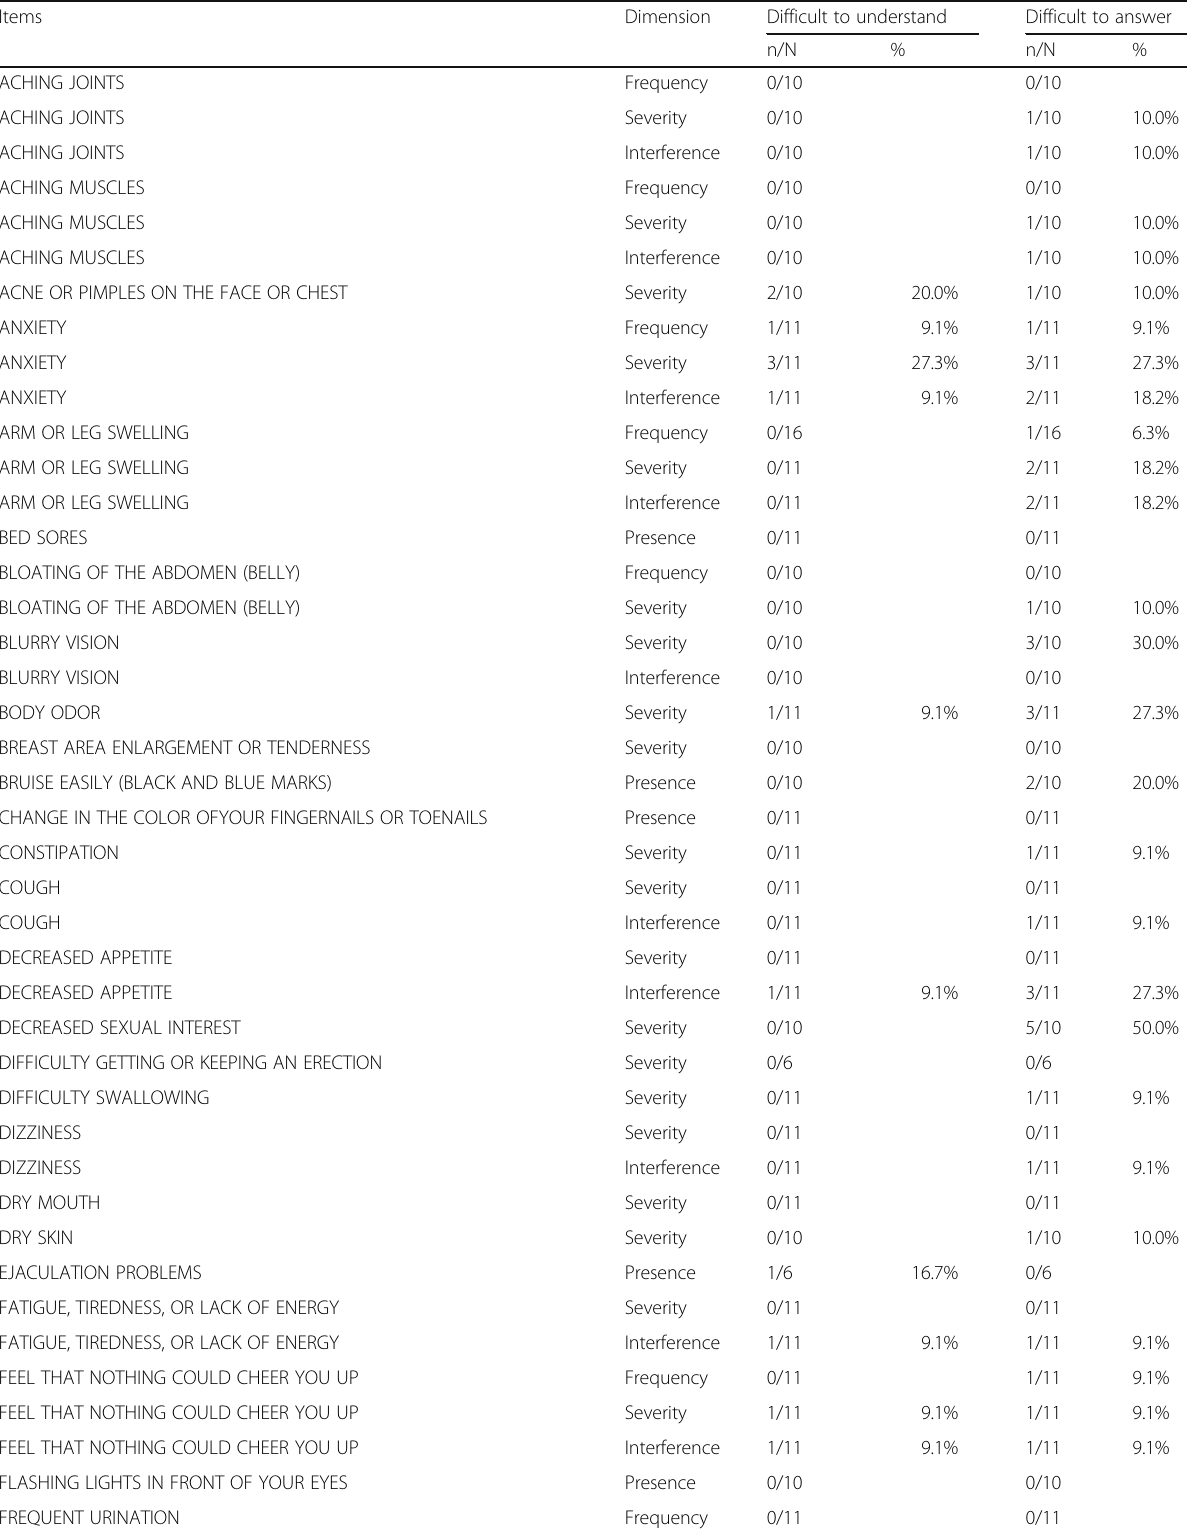
Table 2 Proportion of patients who evaluated items as “ difficult to understand ” or “ difficult to answer